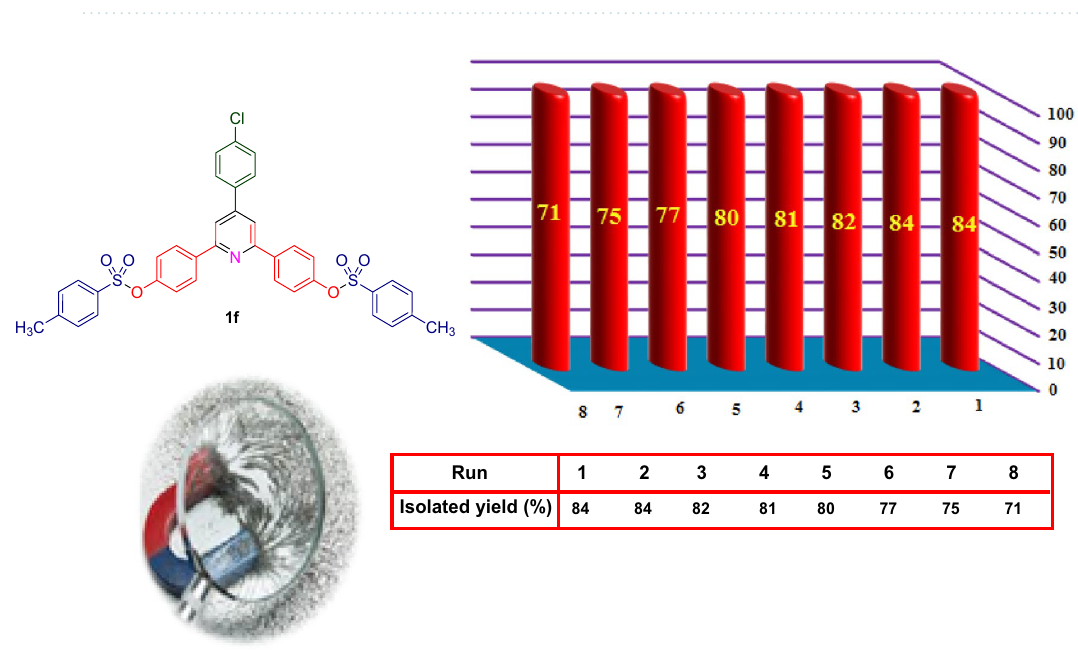
Figure 8. Recovering and reusing test of Fe 3 O 4 @SiO 2 @PCLH-TFA upon the synthesis of 1f